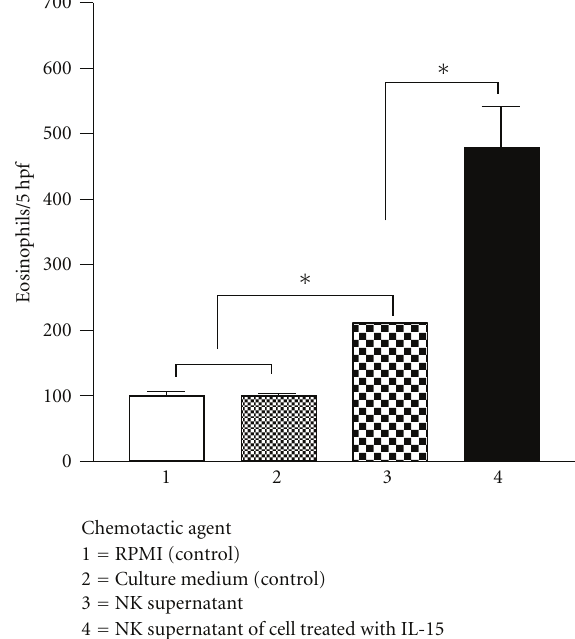
Figure 1: Eosinophilotactic activity of supernatants of resting NK cells versus supernatants of NK cells stimulated with IL-15. Results are the mean ± SEM of 10 independent experiments performed in triplicate. Asterisks indicate P < 0 . 05 by paired t -test.